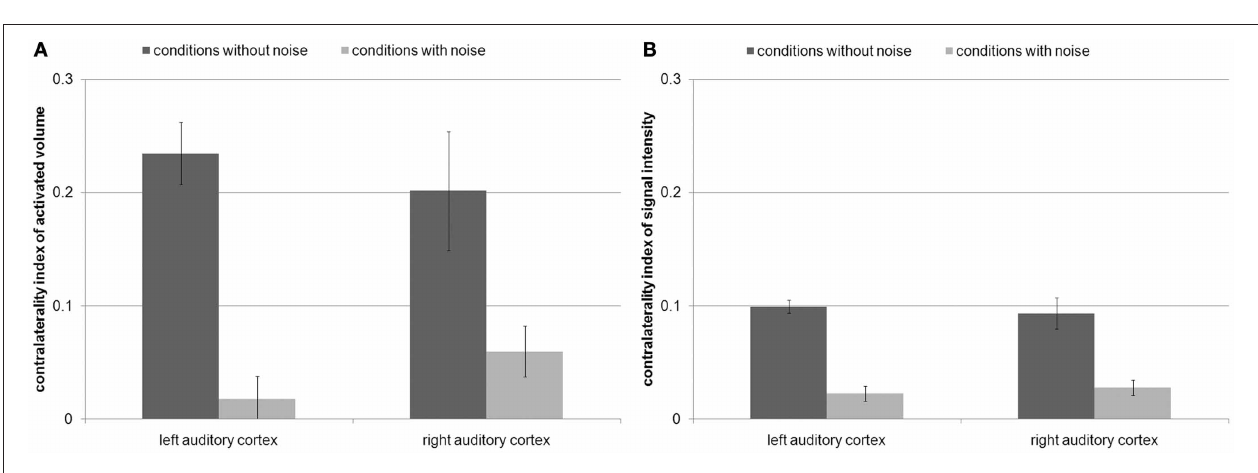
FIGURE 4 | (A) Contralaterality index of the activated volume and (B) contralaterality index of signal intensity with standard errors. This index was computed by contralateral FM presentation minus ipsilateral FM presentation divided by the sum of both conditions. Positive values indicate stronger activity by contralateral FM tones than by